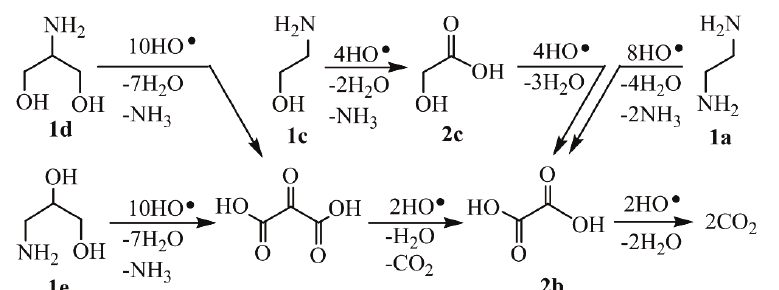
Figure 5. Degradation of 1a , 1c – e (Group A) by HO • radical.